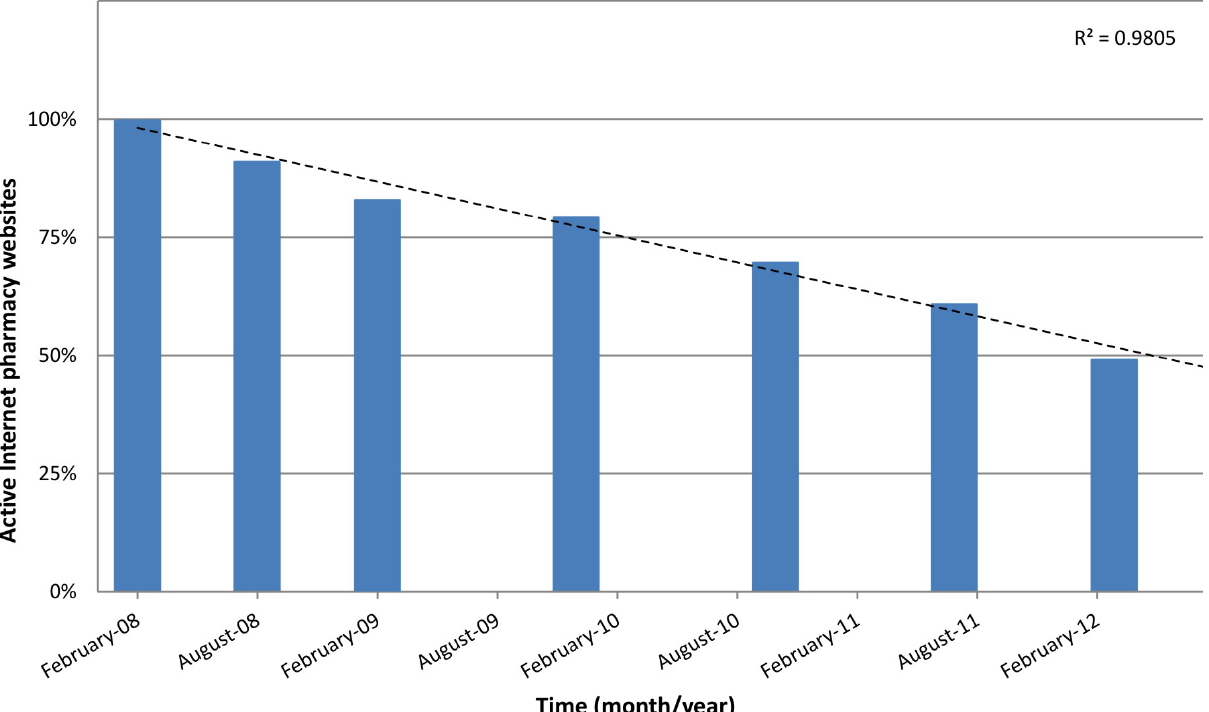
Figure 1. Percentage of active websites (including revival sites) from the original study sample of 136 Internet